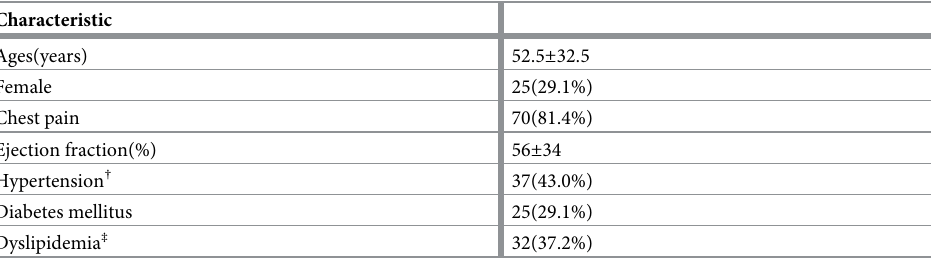
Table 1. The characteristics of the 86